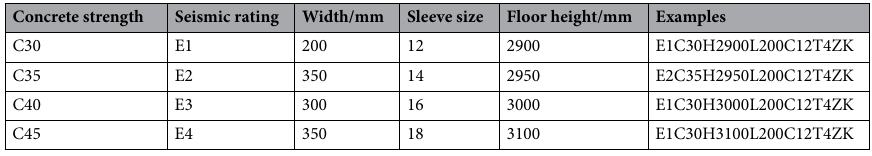
Table 1. Example of edge module code.